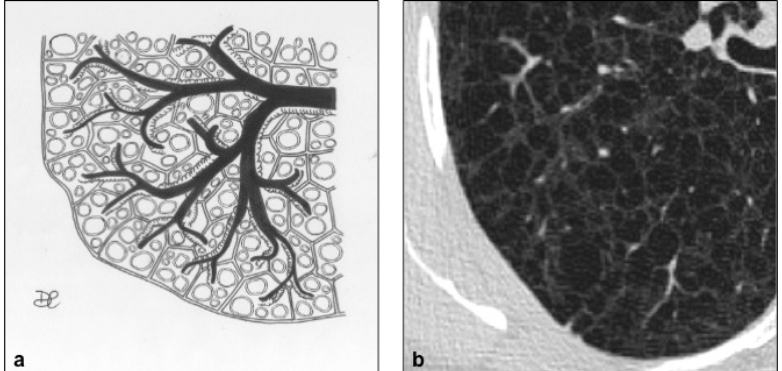
Figure 5. LAM cystic pattern ( a ). Lung cysts with rounded regular shape and thin walls are shown on pictures a and b . This figure has been partially modified from ECR 2017/C-2141 Cystic pattern in lung